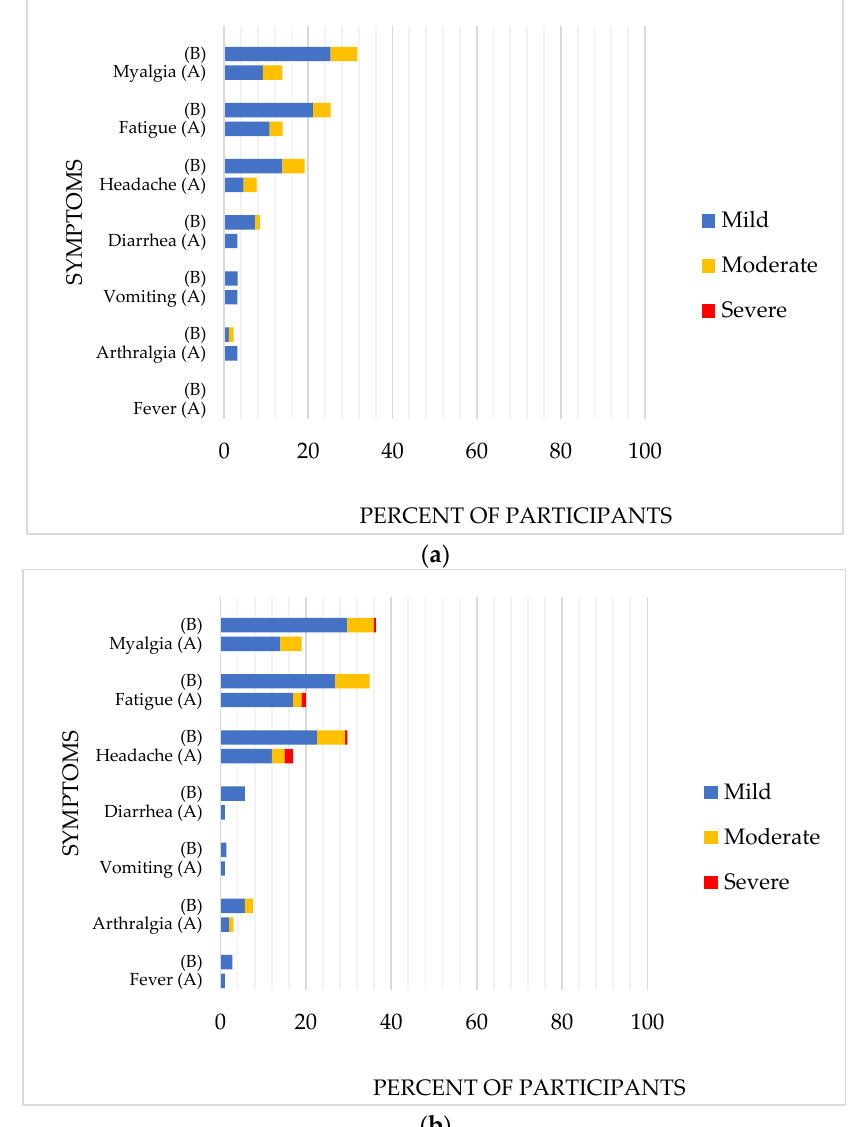
Figure 3. Systemic reactogenicities within 7 d following BNT162b2 among adolescent who are immunocompromised (A), and who have chronic diseases (B); Post dose 1 of BNT162b2 ( a ), Post dose 2 of BNT162b2 ( b ).